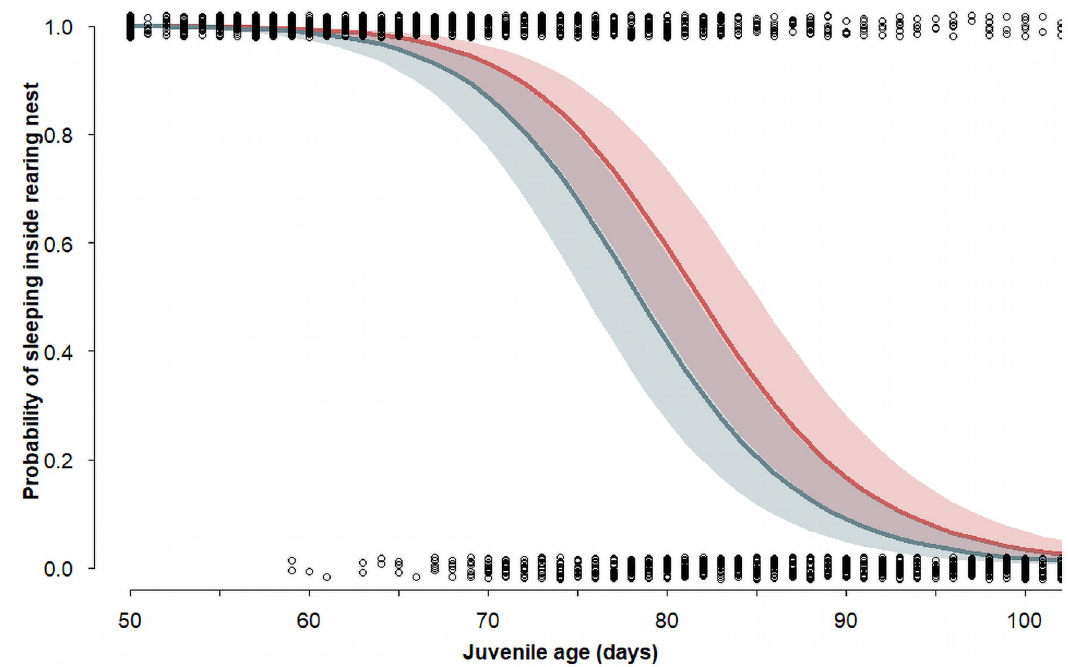
Fig 2. Probability (with 95% CrI) of roosting inside the rearing nest-box in relation to age fitted with a binomial GLMM (Table 1) in juvenile barn owls. The red line represents corticosterone-implanted individuals, the grey-green line placebo- implanted individuals, and circles the raw